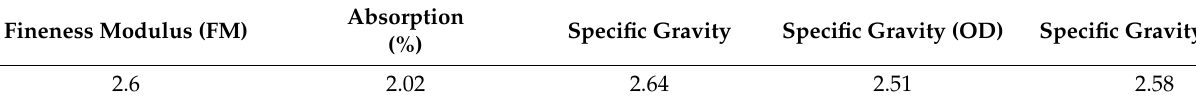
Table 3. Physical properties of sand.